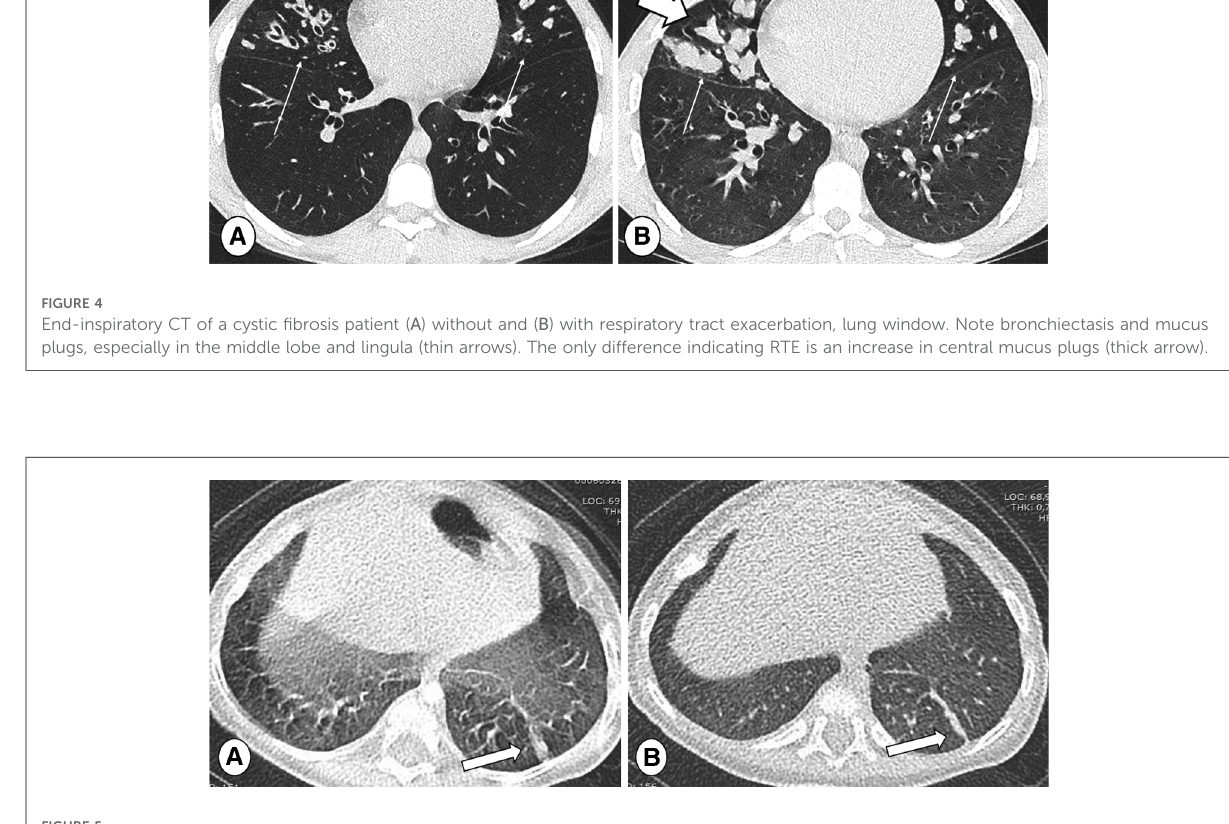
FIGURE 5 Axial CT of 5 months old patients with CF, thickness 0.7 mm, scanned in single source-mode with pitch 1.2 ( A ) and repeated in double source-mode with pitch 3.2 ( B ). Note that respiratory artifacts are absent using an higher pitch acquisition ( B ), providing a high image quality and facilitating the detection of atelectasis in the left lower lobe